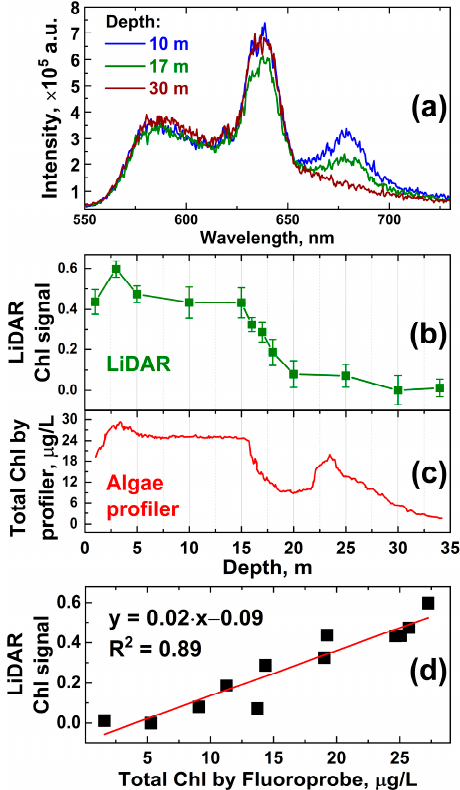
Figure 5. ( a ) LiDAR raw spectra of water samples collected from 10, 17 and 30 m and measured onboard; ( b ) chlorophyll fluorescence signal measured onboard with LiDAR as a function of depth; ( c ) in situ profile of total chlorophyll- a concentration measured by the Fluoroprobe profiler; ( d ) scatter plot illustrating the correlation between LiDAR and Fluoroprobe profiler data with a straight line representing the linear fit of the